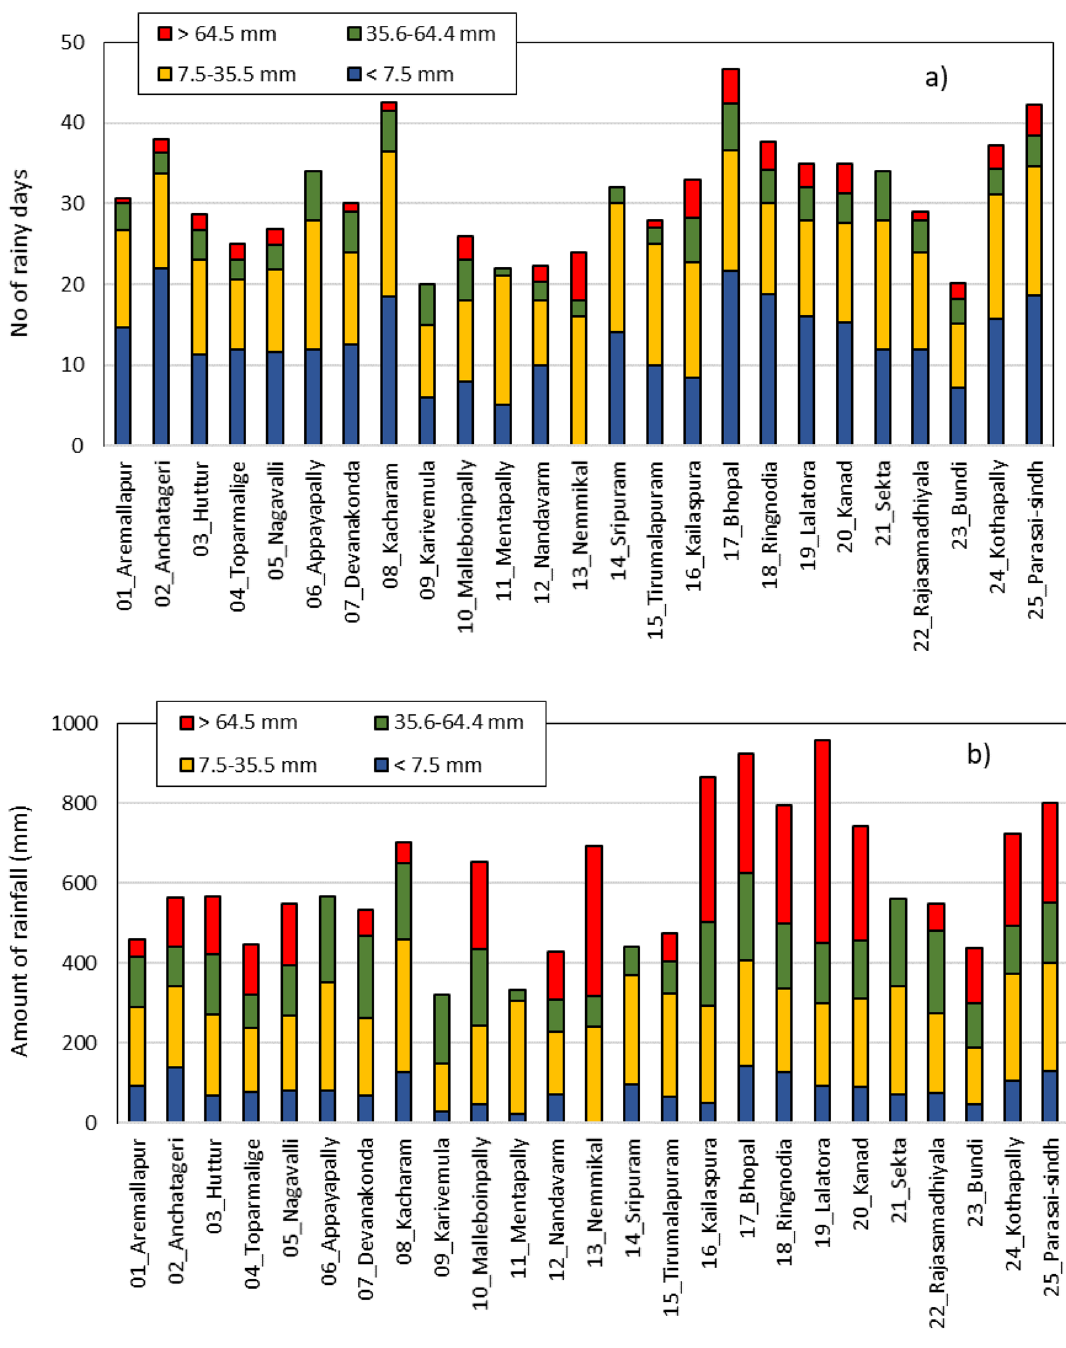
Figure 4. Distribution of rainfall in the study